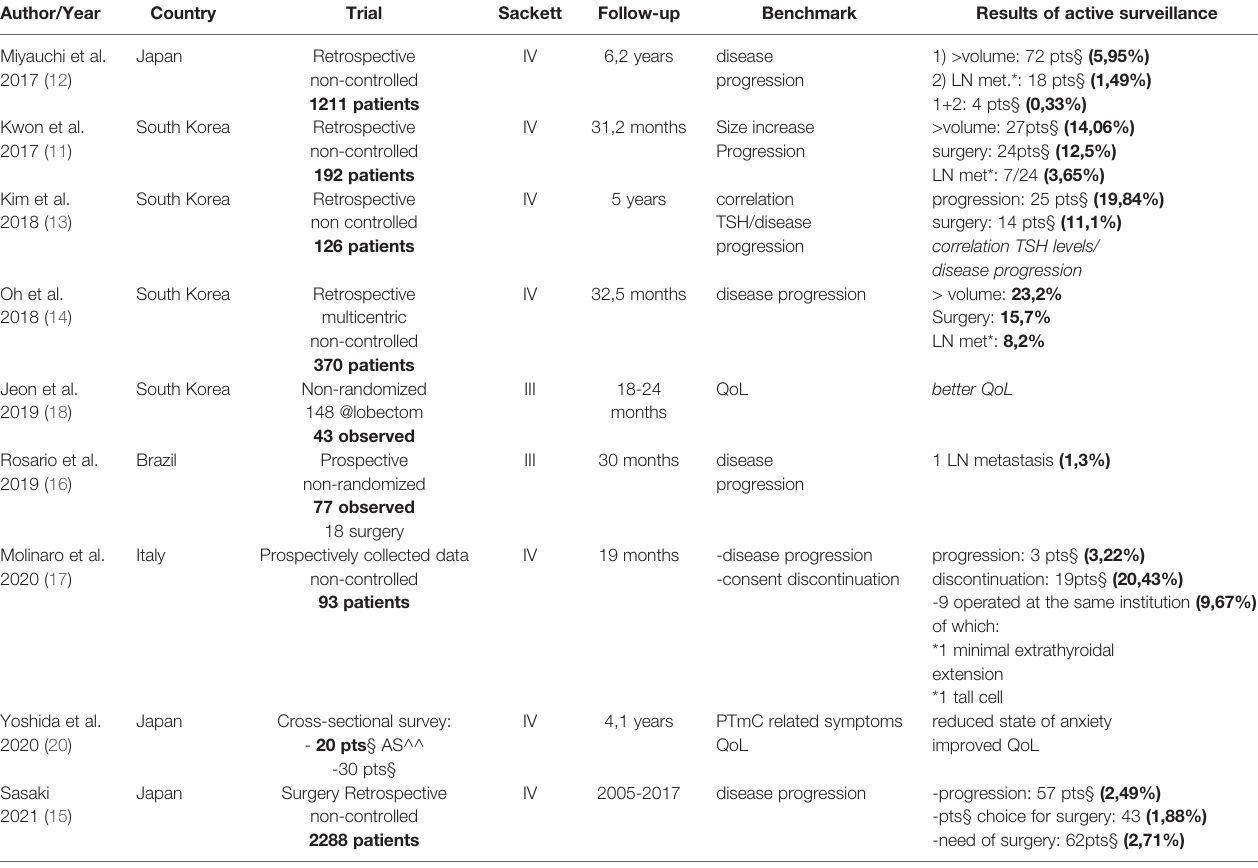
The data reported in this table came from articles included in the systematic review. Sackett:LevelofevidencebasedonSackett ’ sscale:I,meta-analysisorlargerandomizedtrials(clearcut-offresultsandlowriskforerror);II,smallrandomizedtrialsandmoderate/highriskforerror;III, non-randomized but prospective with contemporaneous control trials; IV, non-randomized trials with historical controls or retrospective analysis; V, case series without control; expert opinion. met*, metastasis; Pts§, patients; @lobectom, thyroid lobectomy; QoL, Quality of Life. AS^^, Active Surveillance. Bold values = number of patients enrolled for active